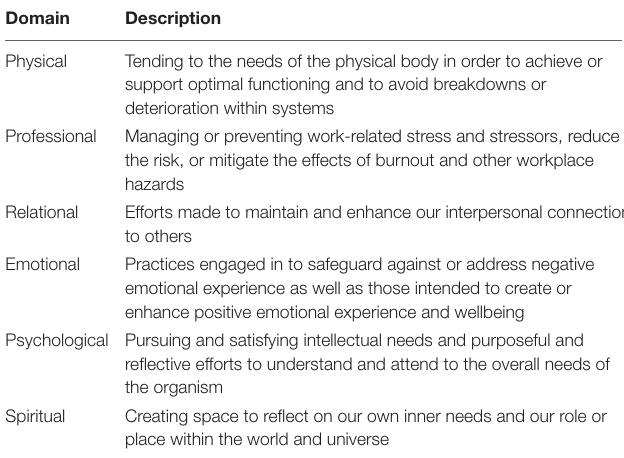
TABLE 2 | Six domains of self-care (Butler et al.,